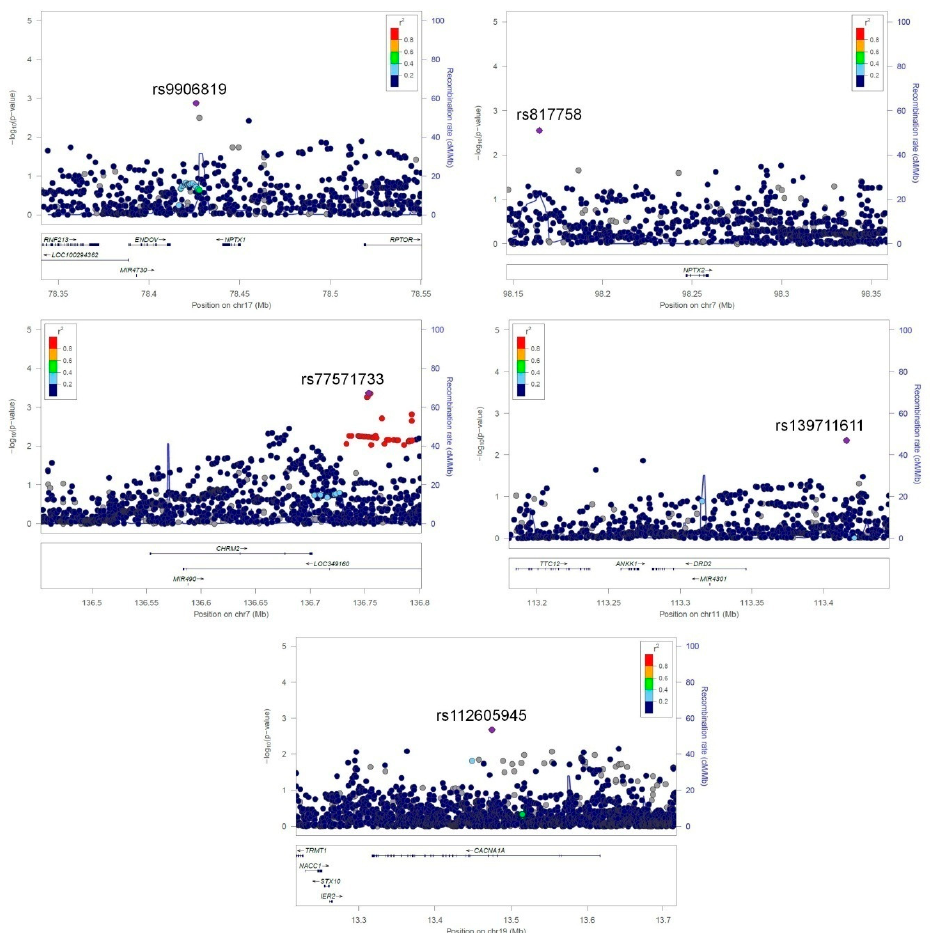
Figure 5. Regional Manhattan plots for selected gene regions from meta-analysis summary.